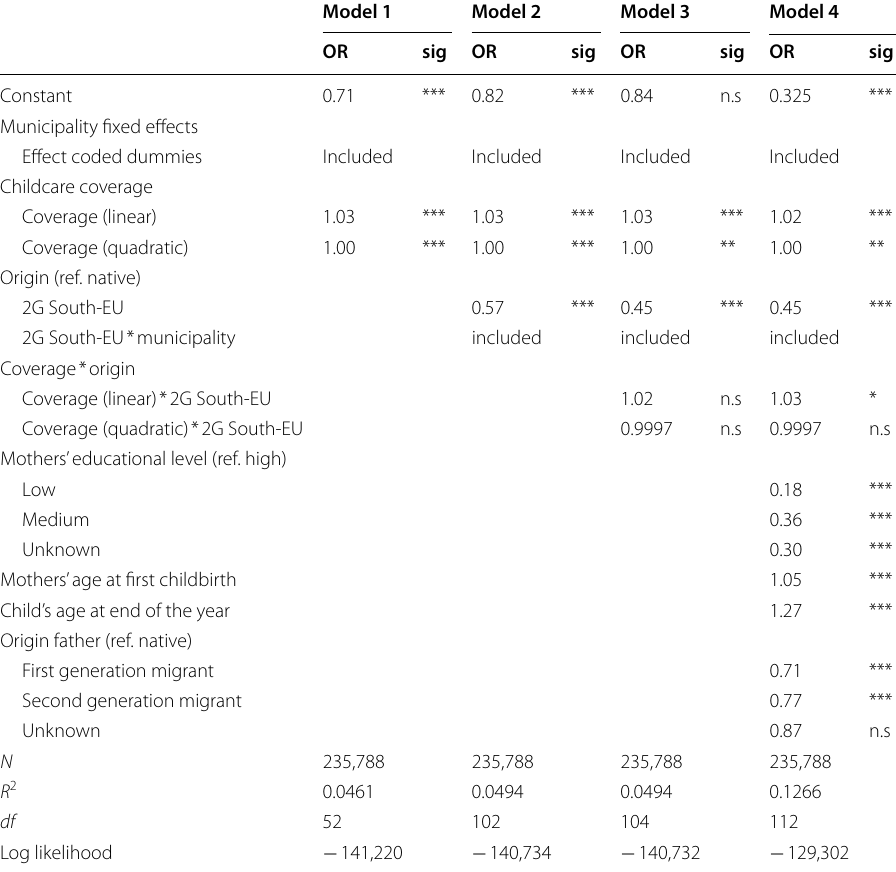
Table 5 Municipality-level fixed-effects logit models for the uptake of formal childcare, native and second generation Southern European